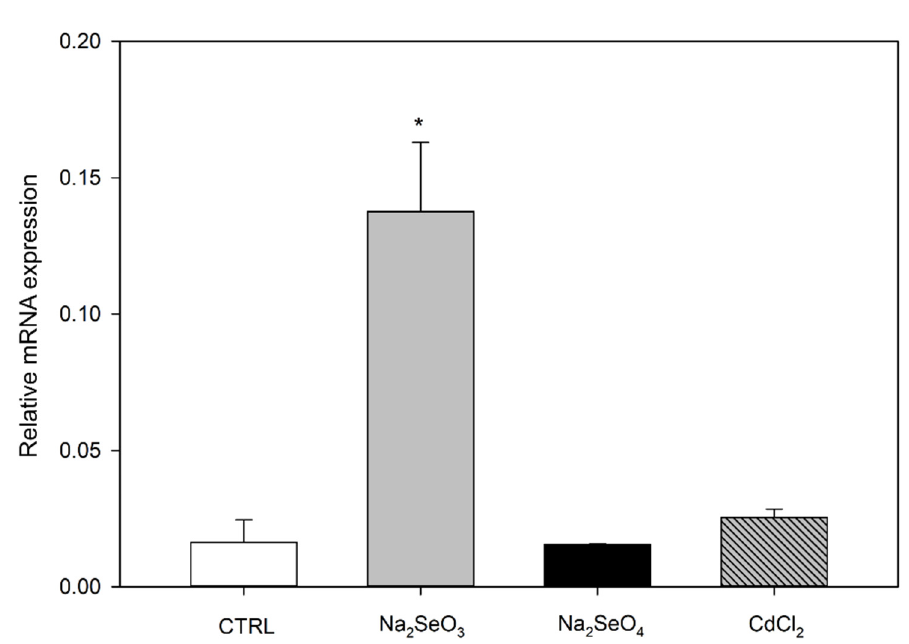
Figure 2. Relative expression levels of At SAH7 in Arabidopsis thaliana roots treated with selenium compounds (selenite, Na 2 SeO 3 ; selenate, Na 2 SeO 4 ) and cadmium (CdCl 2 ). Significant upregulation of At SAH7 was observed after selenite (Na 2 SeO 3 ) treatment. Values ± SD were normalized to the mean of UBQ10 and represent the mean of three biological samples analyzed in triplicate. Significant differences at p ≤ 0.05 are indicated by